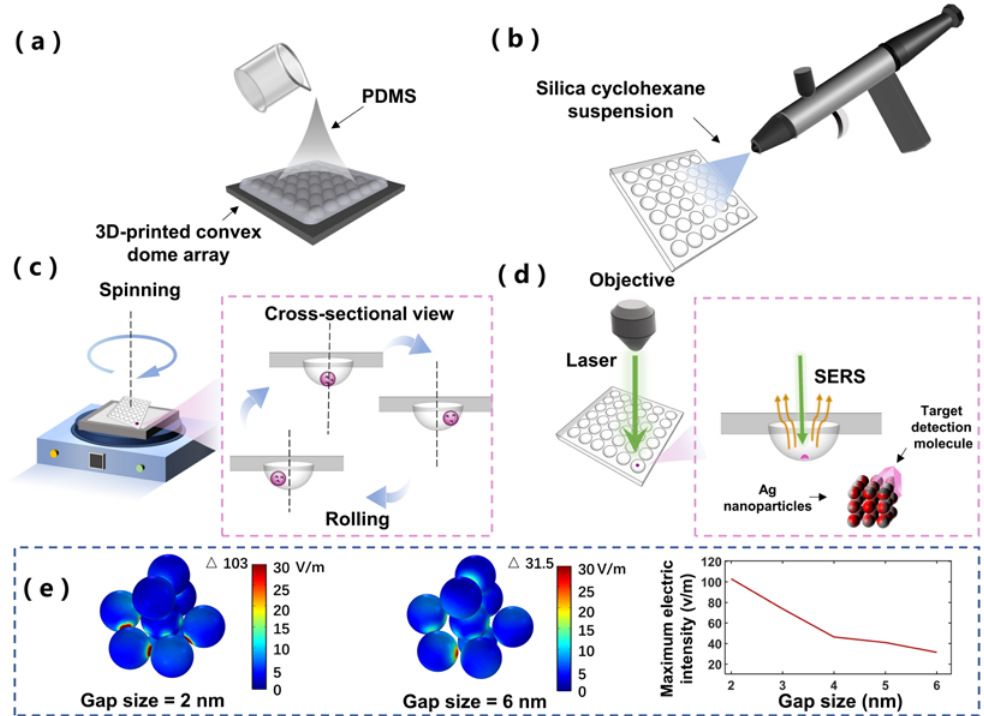
Figure 1. ( a ) Schematic diagram of concave dome array preparation; ( b ) schematic diagram of superhydrophobic surface coating; ( c ) schematic diagram of working mechanism of dynamic enrichment on SCDA; ( d ) schematic diagram of surface-enhanced Raman scattering (SERS) detection on SCDA; ( e ) numerical simulation of electric field intensity of Ag nanoparticles with different gap sizes in three-dimensional space.